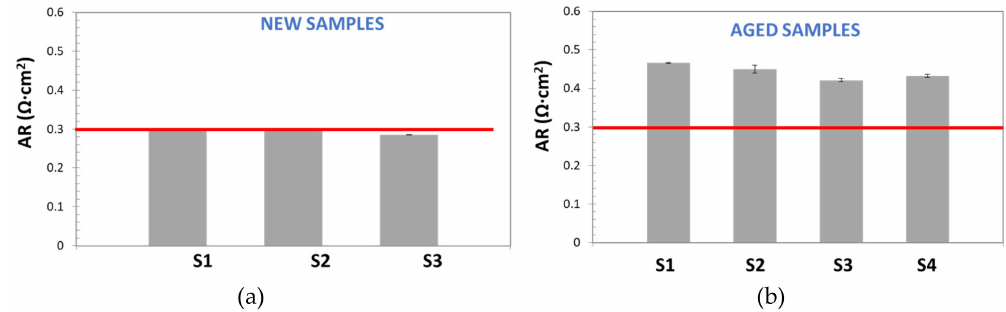
Figure 16. Area resistance values calculated by Zero-Gap EIS method for: ( a ) New diaphragm samples ( b ) Used